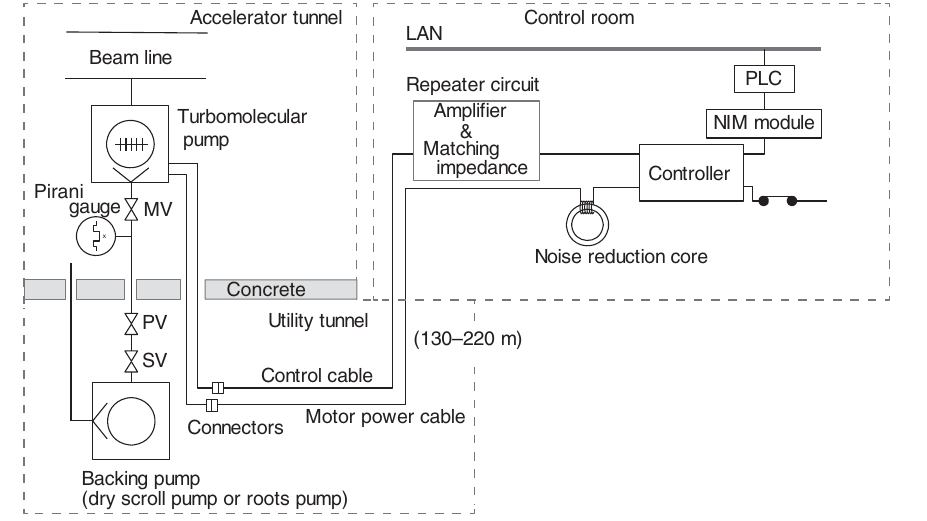
FIG. 11. Configuration diagram of the improved TMP system using the controller with the long cable specification. The controller is 220 m away from the TMP in maximum. There is no radiation influence in the control